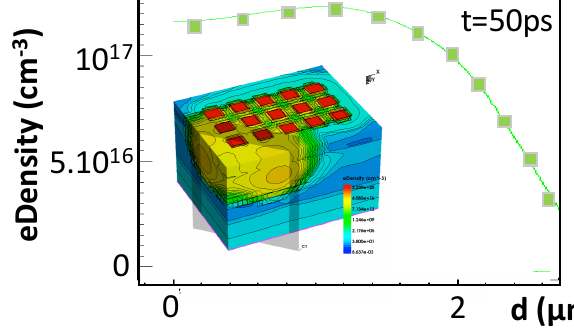
Fig. 14. Electron density along the particle track for the alpha particle.